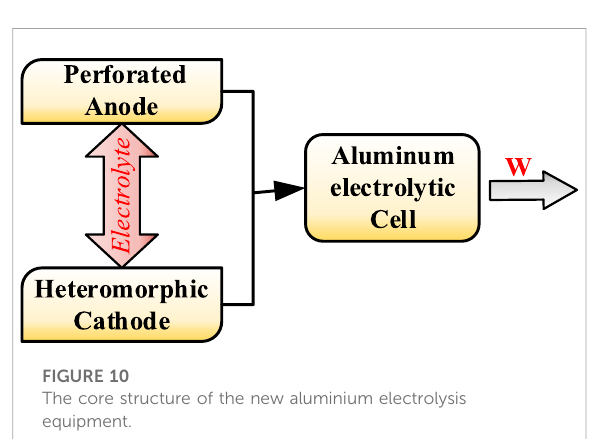
FIGURE 9 The fl ow chart of EGAWNN.